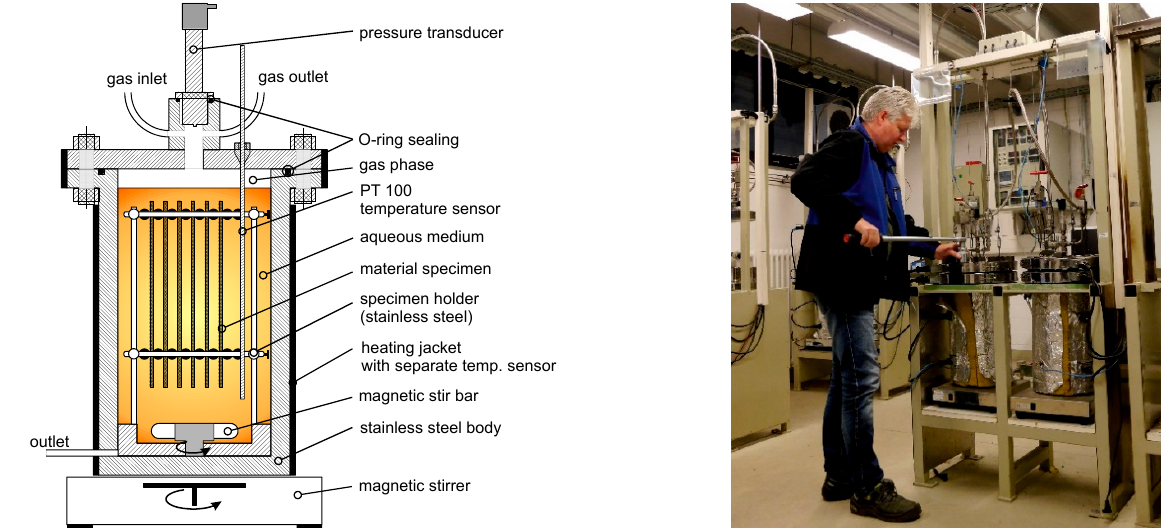
Figure 1. Schematic view of autoclave test equipment (left), closing the cover plate of the autoclaves (test rig with two autoclaves).